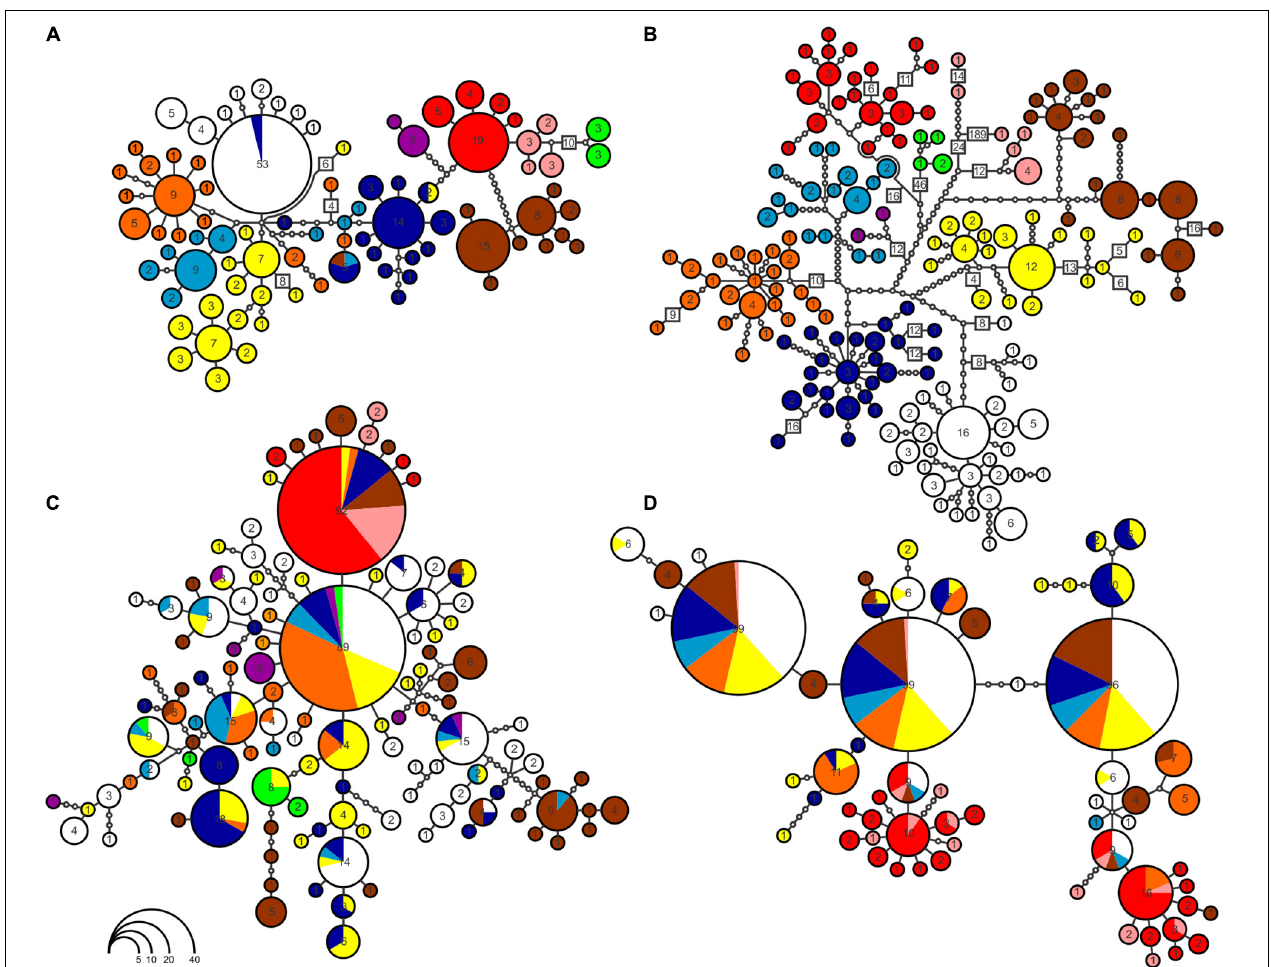
FIGURE 3 | Haplotype networks built for the four markers used in the study: (A) 16S; (B) CYTB; (C) DNAH3; (D) SINCAIP. Not all groups were completely sampled in haplotype networks, due to PCR failure. Colors correspond to same scheme of Figures 1 , 2 . Circle sizes are proportional to the number of individuals of each haplotype. Intermediate points (smallest circles) refer to the number of mutational steps between populations. To facilitate visualization the total number of mutations was indicated in some segments.